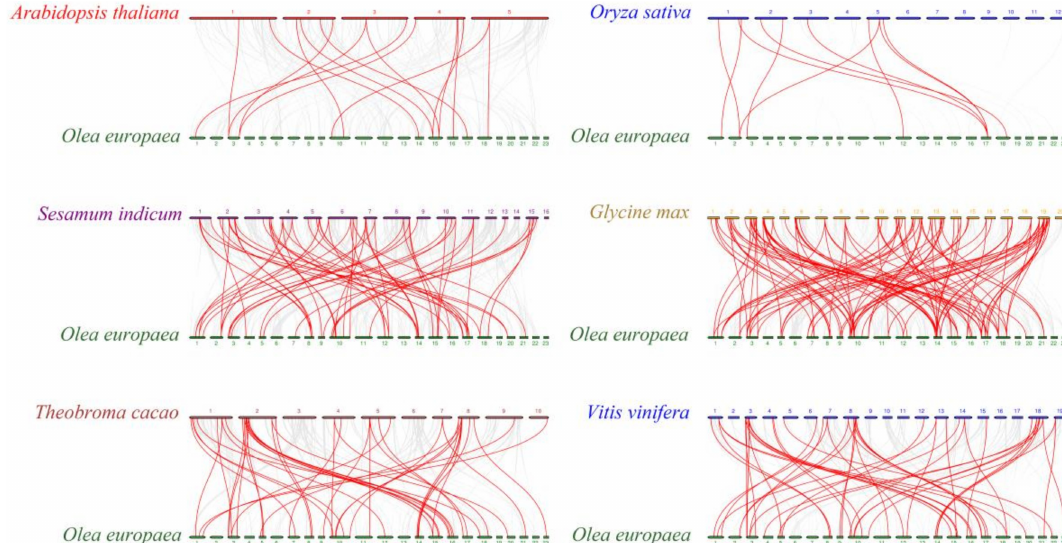
Figure 5. Synteny analysis of OebZIP with other species ( Arabidopsis thaliana , Sesamum indicum , Glycine max , Vitis vinifera L., Theobroma cacao, and Oryza sativa L.). Gray lines represent collinear blocks within olive and other species, while red lines represent syntenic bZIP gene